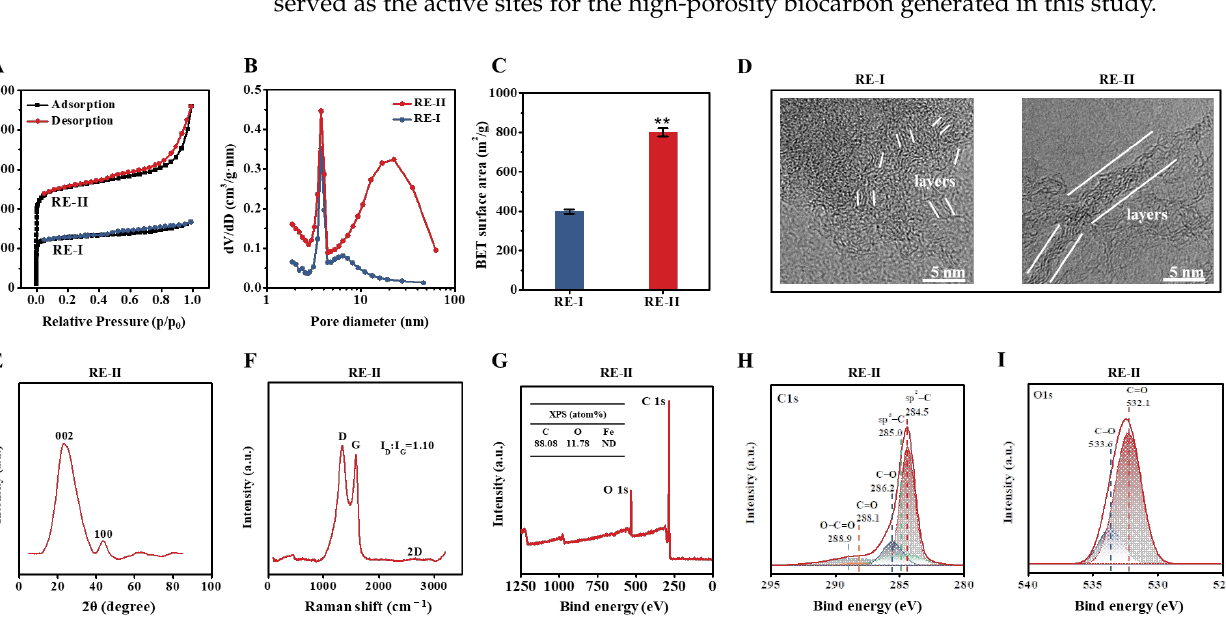
Figure 5. Characterization of the porous carbons generated by 1:2 ( w / w ) FeCl 3 -activated thermal– chemical conversion of the lignocellulose residues (RE) from T. reesei incubation with raw ZH stalk co-supplied with 0.05% FeCl 3 . ( A – C ) For the two carbon generated from RE-I (Raw + 0.05% FeCl 3 ) and RE-II (Raw + 0.05% FeCl 3 ) + 1:2 FeCl 3 : ( A ) TEM observation; ( B ) nitrogen adsorption/desorption isotherm profiling; ( C ) pore-size-distribution profiling; ( D ) BET surface-area assay. ( E – I ) For the carbon sample generated from RE-II: ( E ) X-ray assay; ( F ) Raman-spectra profiling; ( G ) XPS-spectra region ( I ). ** a significant difference between two lignocellulose residues at p < 0.05 or 0.01